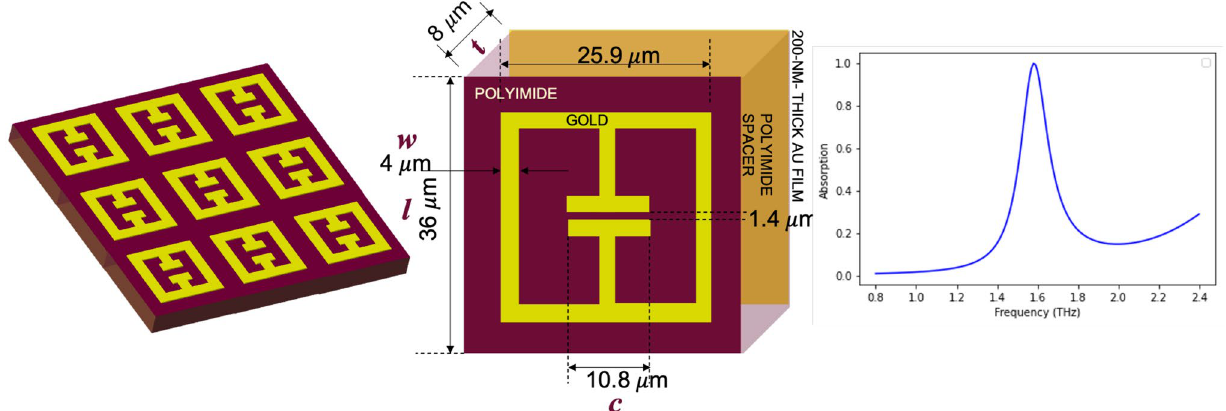
Figure 3. Schematic of a terahertz dielectric absorber comprising of a dual metallic and a dual dielectric layer structure 23 composed of split-ring resonator unit cells arranged in a regularly spaced array (left). Dimensional parameters of an SRR unit cell (center) of a metamaterial optimized to demonstrate near-unity absorption at 1.6 THz